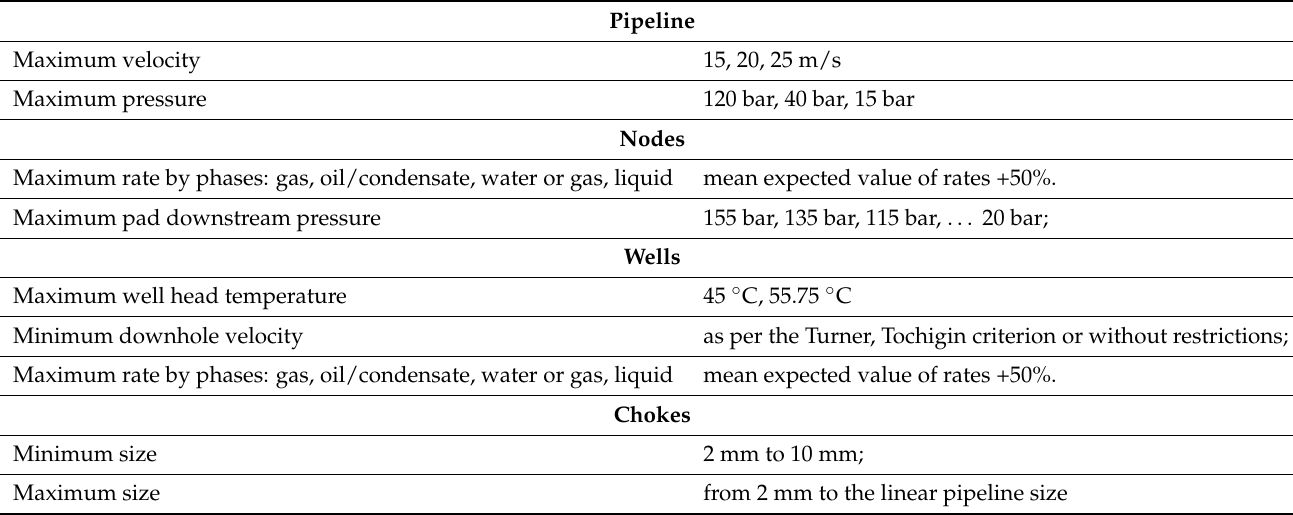
Table 1. Sample of the restriction ranges for the target function